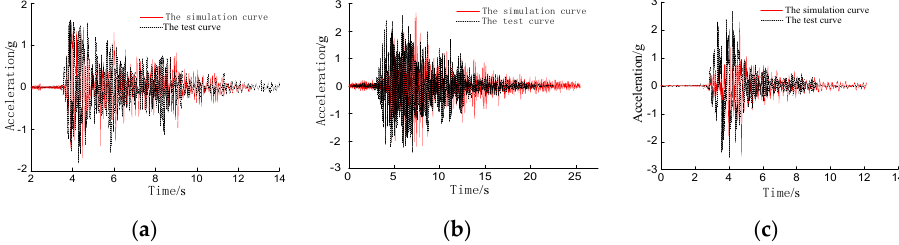
Figure 13. Comparison diagram of the acceleration simulation and test on top of an uncontrolled tower under an 8-degree large earthquake. ( a ) El-Centro record. ( b ) Jiangyou record. ( c ) Artificial wave.